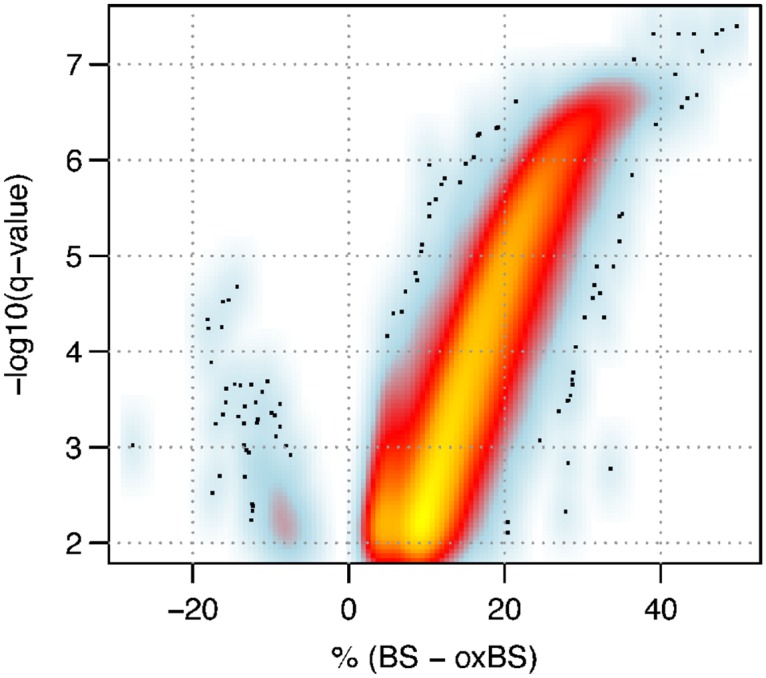
Distribution of 5hmC levels.Only probes which were significantly differentially methylated between BS and oxBS are shown hence the lack of probes around zero. For the plot of all probes see S5 Fig. Negative values fall within the expected 1% FDR.